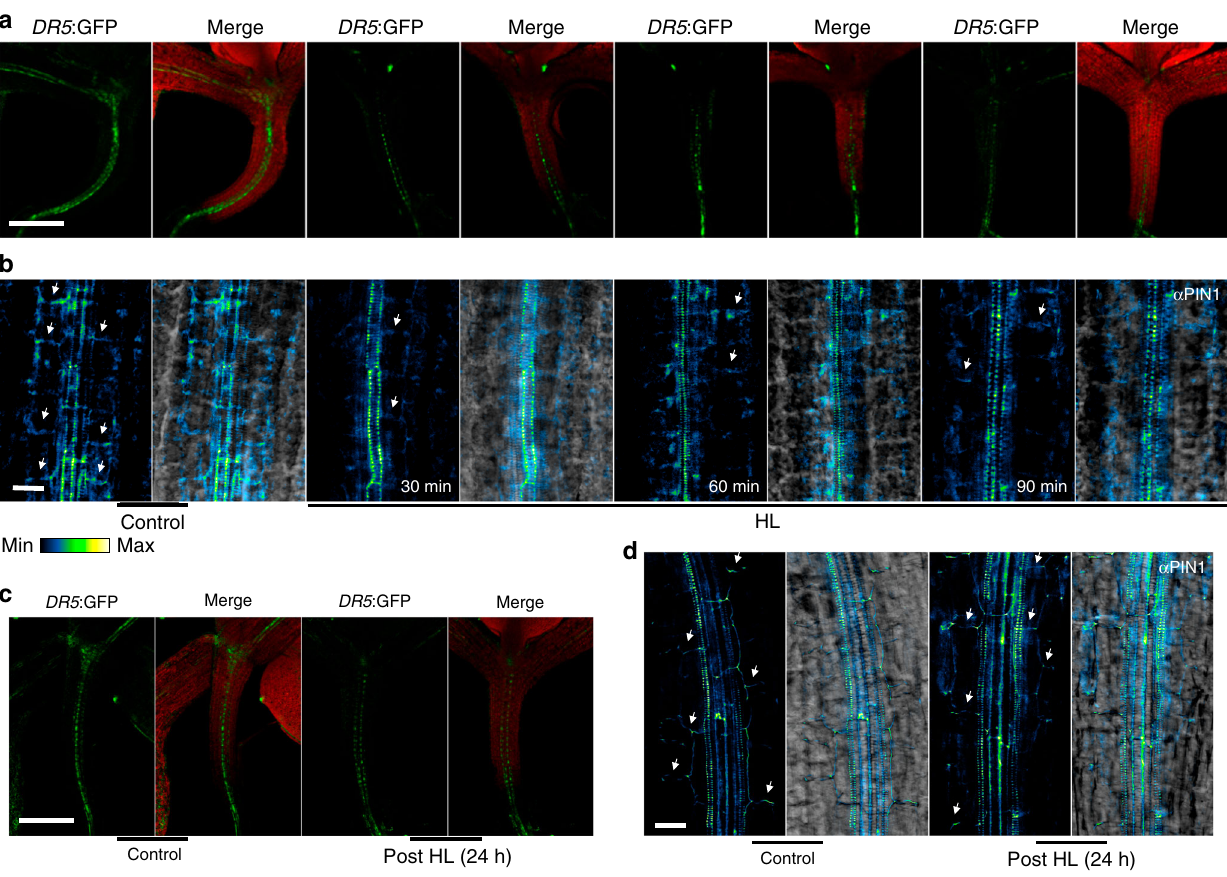
Fig. 5 High light reduces DR5 :GFP and PIN1 abundance. a, b Representative images of DR5 :GFP and PIN1 abundance in 7-day hypocotyls of P seedlings after high light (HL) treatment. a DR5 :GFP (green), chloroplast fl uorescence (red) and merged images. b PIN1 immunolocalization in hypocotyls of P seedlings using α PIN1 antibody (left) and merged image with bright fi eld (right). c, d Recovery of DR5 :GFP and PIN1 at the PM at 24 h post HL treatment, respectively. The color-coded bar displays the PIN1 fl uorescence intensity. All images are representatives of three independent experiments with n ≥ 8 biological replicates each. Scale bars: 100 μ m ( a , c ) and 20 μ m ( b , d